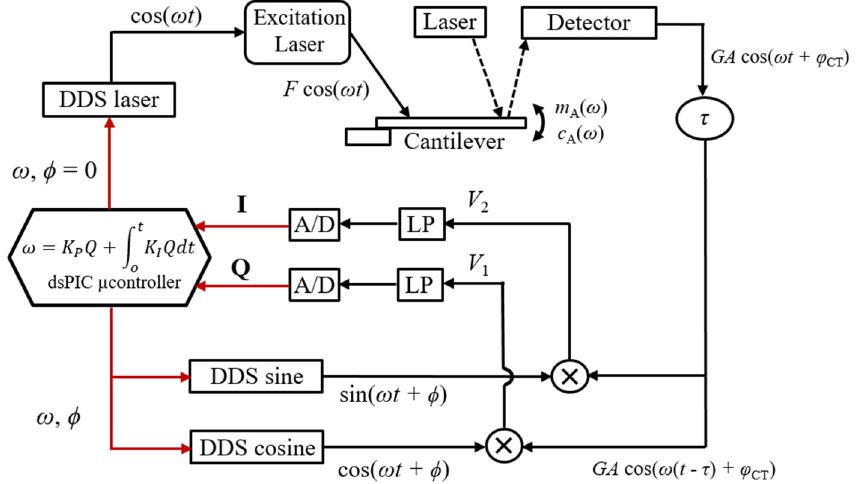
Figure 1. Schematic of the developed PLL